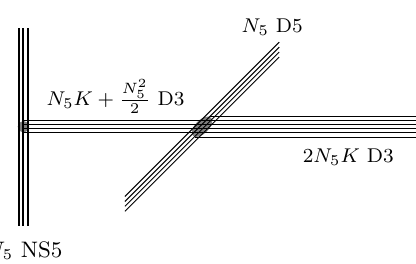
Figure 1. Semi-infinite D3-branes ending on a combination of N 5 D5-branes and N 5 NS5-branes. The D3-branes extend along the (0123) directions, the D5-branes along (012456) and the NS5-branes along (012789). All NS5-branes have the same net number of D3-branes ending on them, and likewise for the